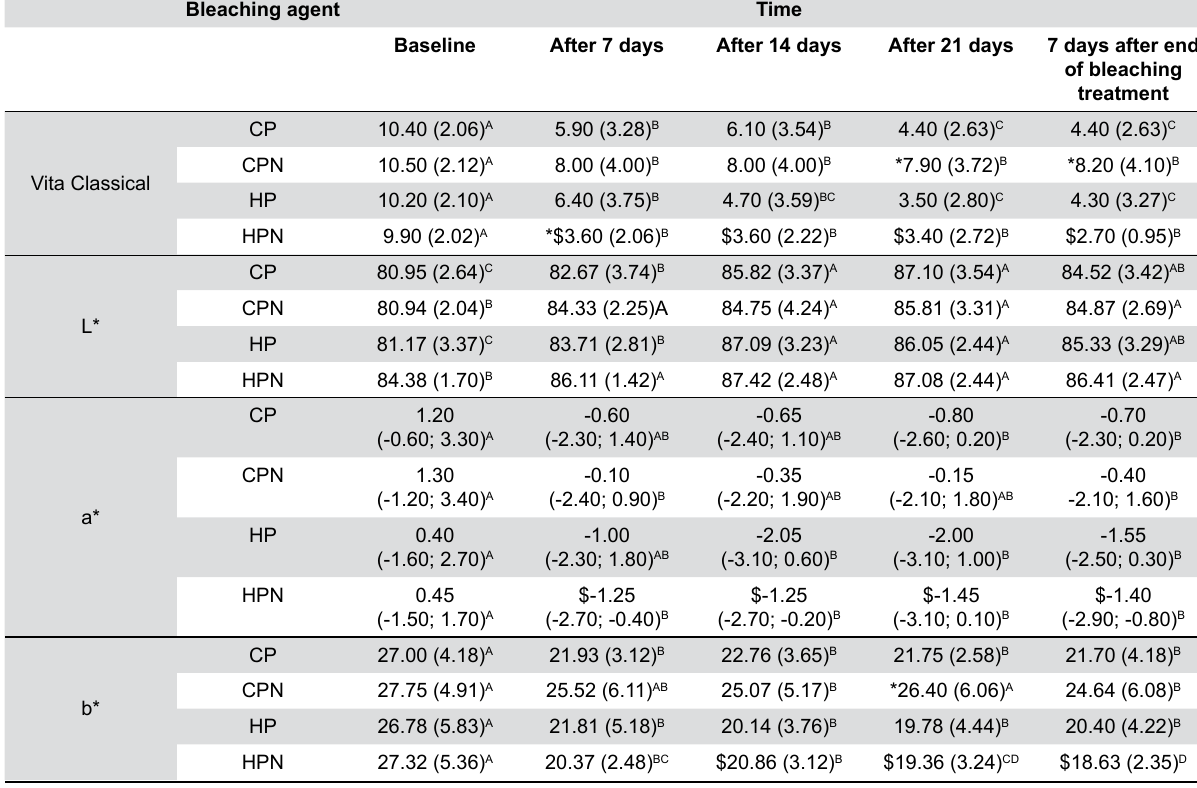
Table 3- Mean (standard deviation) of Vita Classical color variables L* and b* as a function of group and of time-point, and median (minimum value; maximum value) of parameter a* as a function of group and time-point